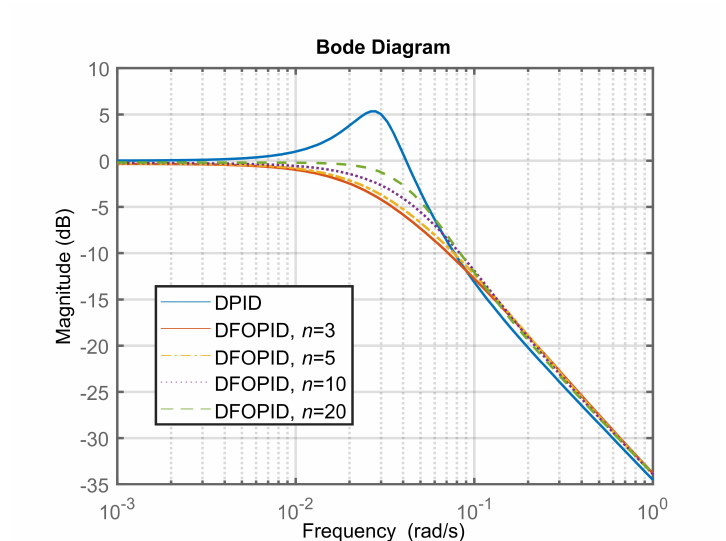
Figure 12. Comparison of singular values of the integer- and non-integer-order discrete PID control systems, for different approximation orders ( n ) of power series expansion (PSE) Tustin, λ = 0.89 and µ = 1.11, T s = 0.15